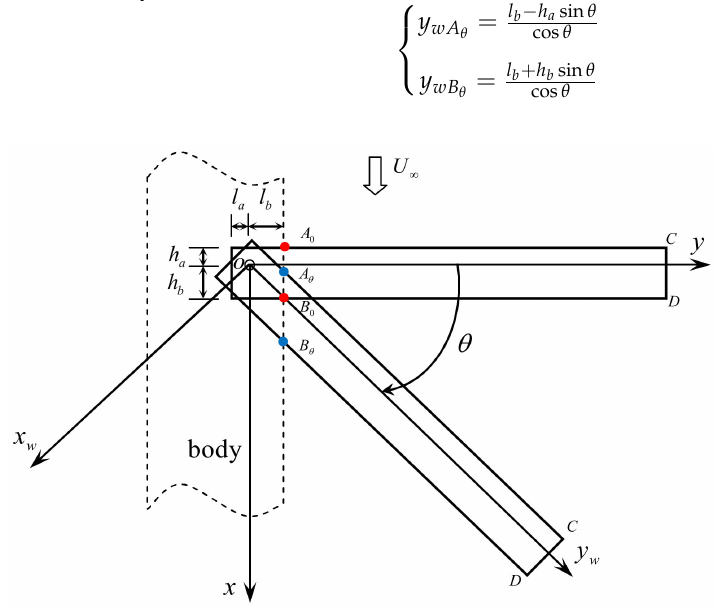
Figure 6. The time-varying effective lifting surface.